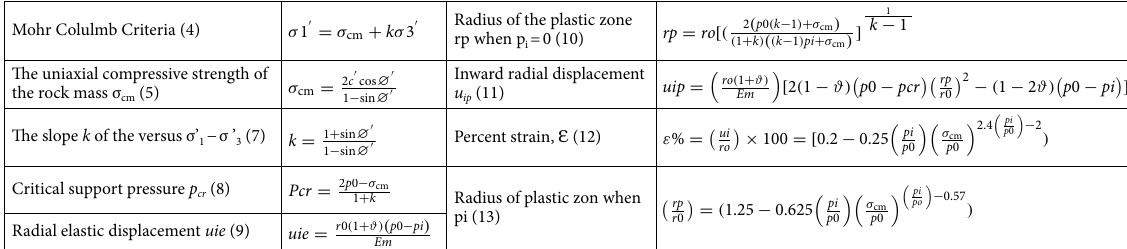
Table 3. Closed form solution equation 8,35 . rp = Plastic zone radius, ui = Tunnel sidewall deformation, ro = Original tunnel radius in metres, pi = Internal support pressure, po = In situ stress = depth below surface × unit weight = p 0 = γ × h , σ cm = Rock mass strength = 2 cosø/(1 − sinø), Em = Young’s modulus or deformation modulus and, υ = Poisson’s ratio, σ ʹ 1 = the axial stress at which failure occurs, σ ʹ 3 = the confining stress, c ʹ = the cohesive strength, ø ʹ = the angle of friction of the rock mass.